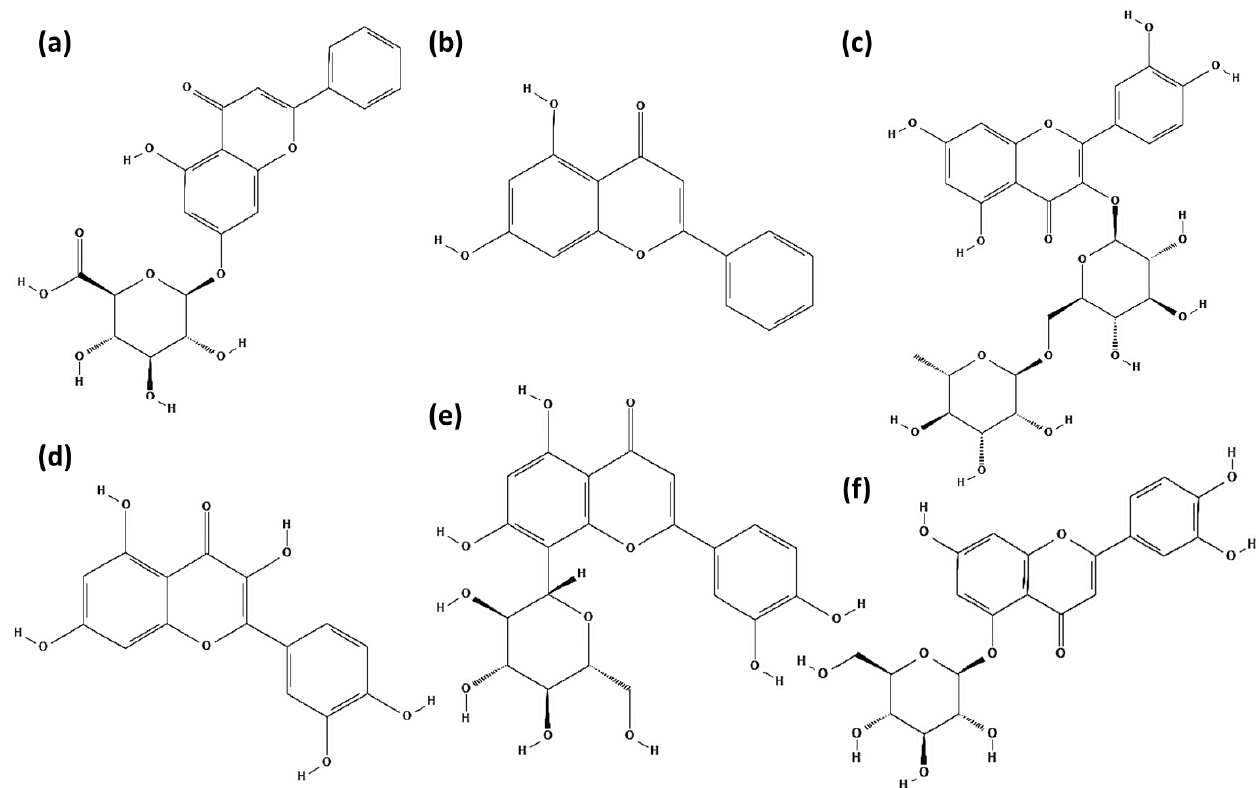
Figure 2. Some examples of flavonoids identified in C. multiflorus : ( a ) Chrysin 7- O -beta-D- glucopyranuronoside; ( b ) Chrysin; ( c ) Rutin; ( d ) Quercetin; ( e ) Orientin; and ( f ) Luteolin-5- O -